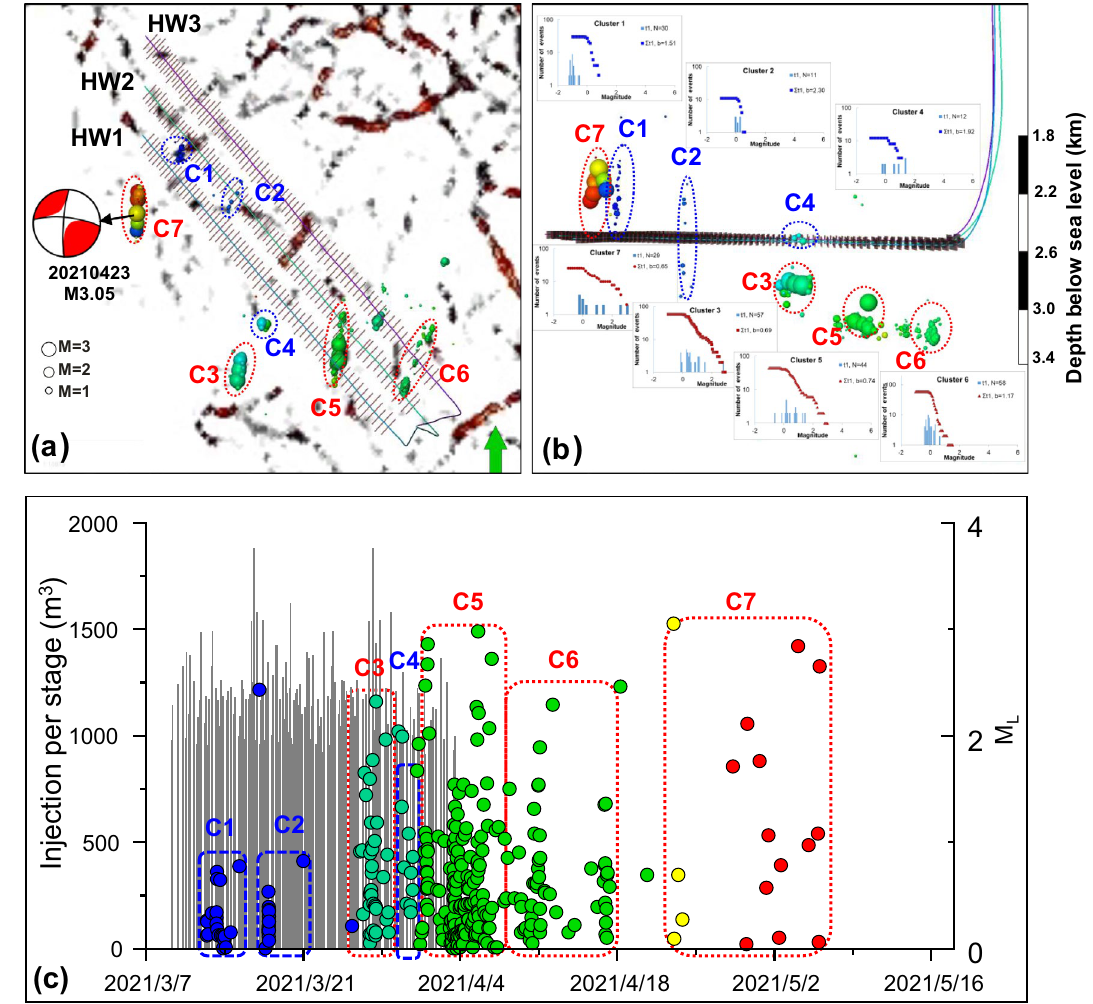
Figure 7. Fracturing operations of three new wells and related induced seismicity. ( a ) Map vies of three fracturing wells superimposed on the pre-existing inferred fault networks. The balls represent the induced earthquakes, colored by time and scaled by magnitude. C1–C7 represent seven earthquake clusters. C1, C2 and C4 were attributed to hydraulic fracture propagation, while the others were linked to reactivation of inferred faults. The beachball shows the focal mechanism solution of the M3.05 event. ( b ) Profile view of HF-induced seismicity and fracturing horizontal wells. Inset maps show the semi-logarithmic magnitude versus frequency distribution for seven clusters. ( c ) Temporal view of treatment data for the three horizontal wells as well as the induced